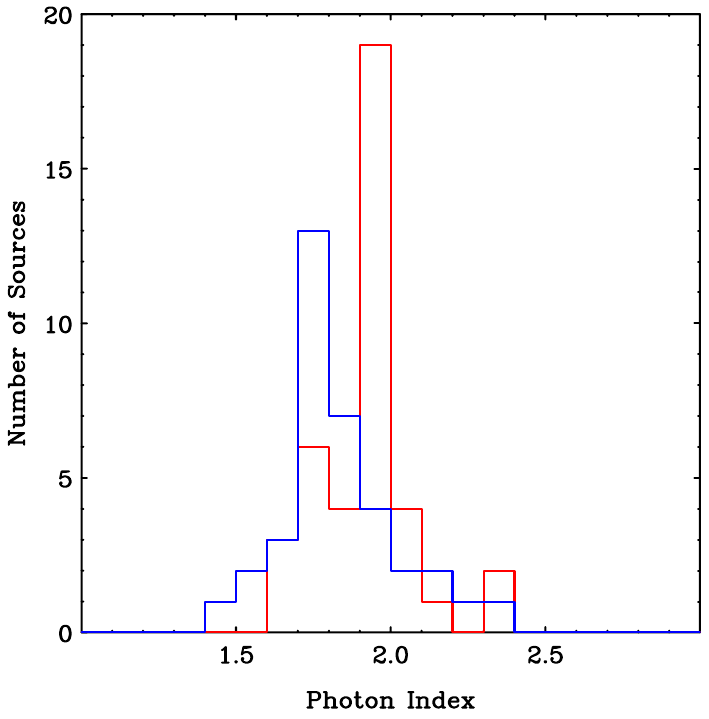
Figure 3. Distribution of Γ of local Seyferts determined from the Swift/BAT survey. Red and blue correspond to type 1 and type 2 AGNs, respectively. Taken from Ueda et al.